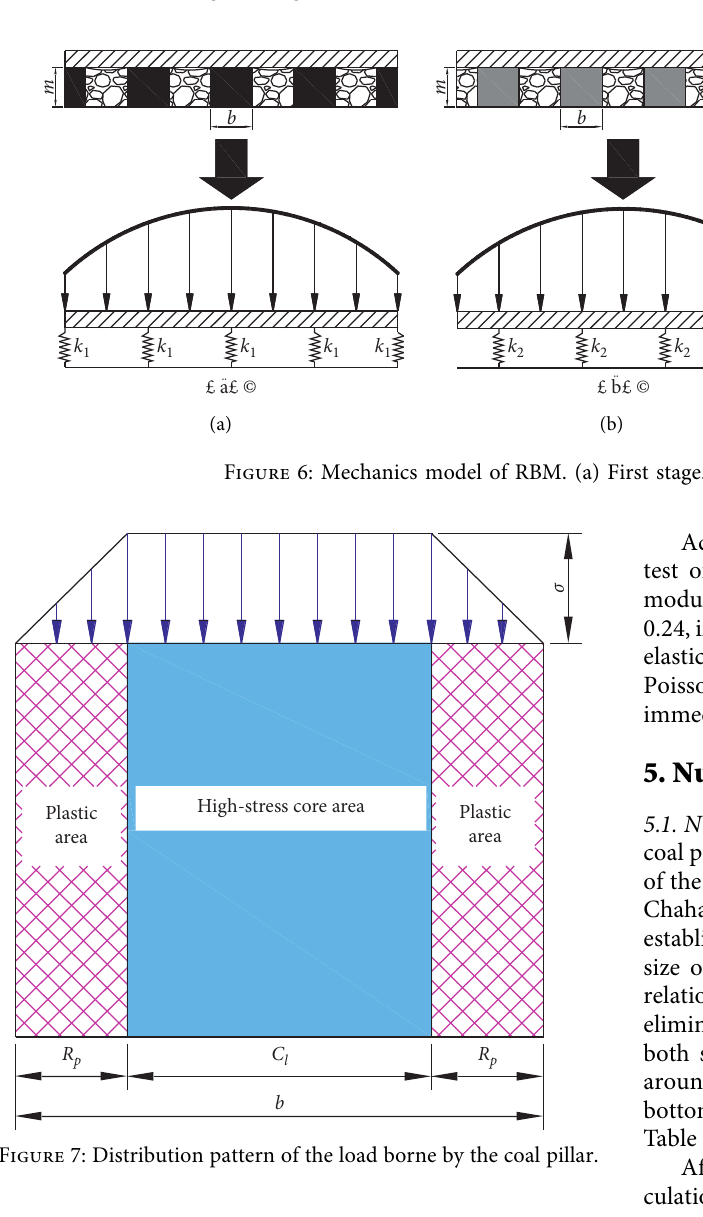
Figure 7: Distribution pattern of the load borne by the coal